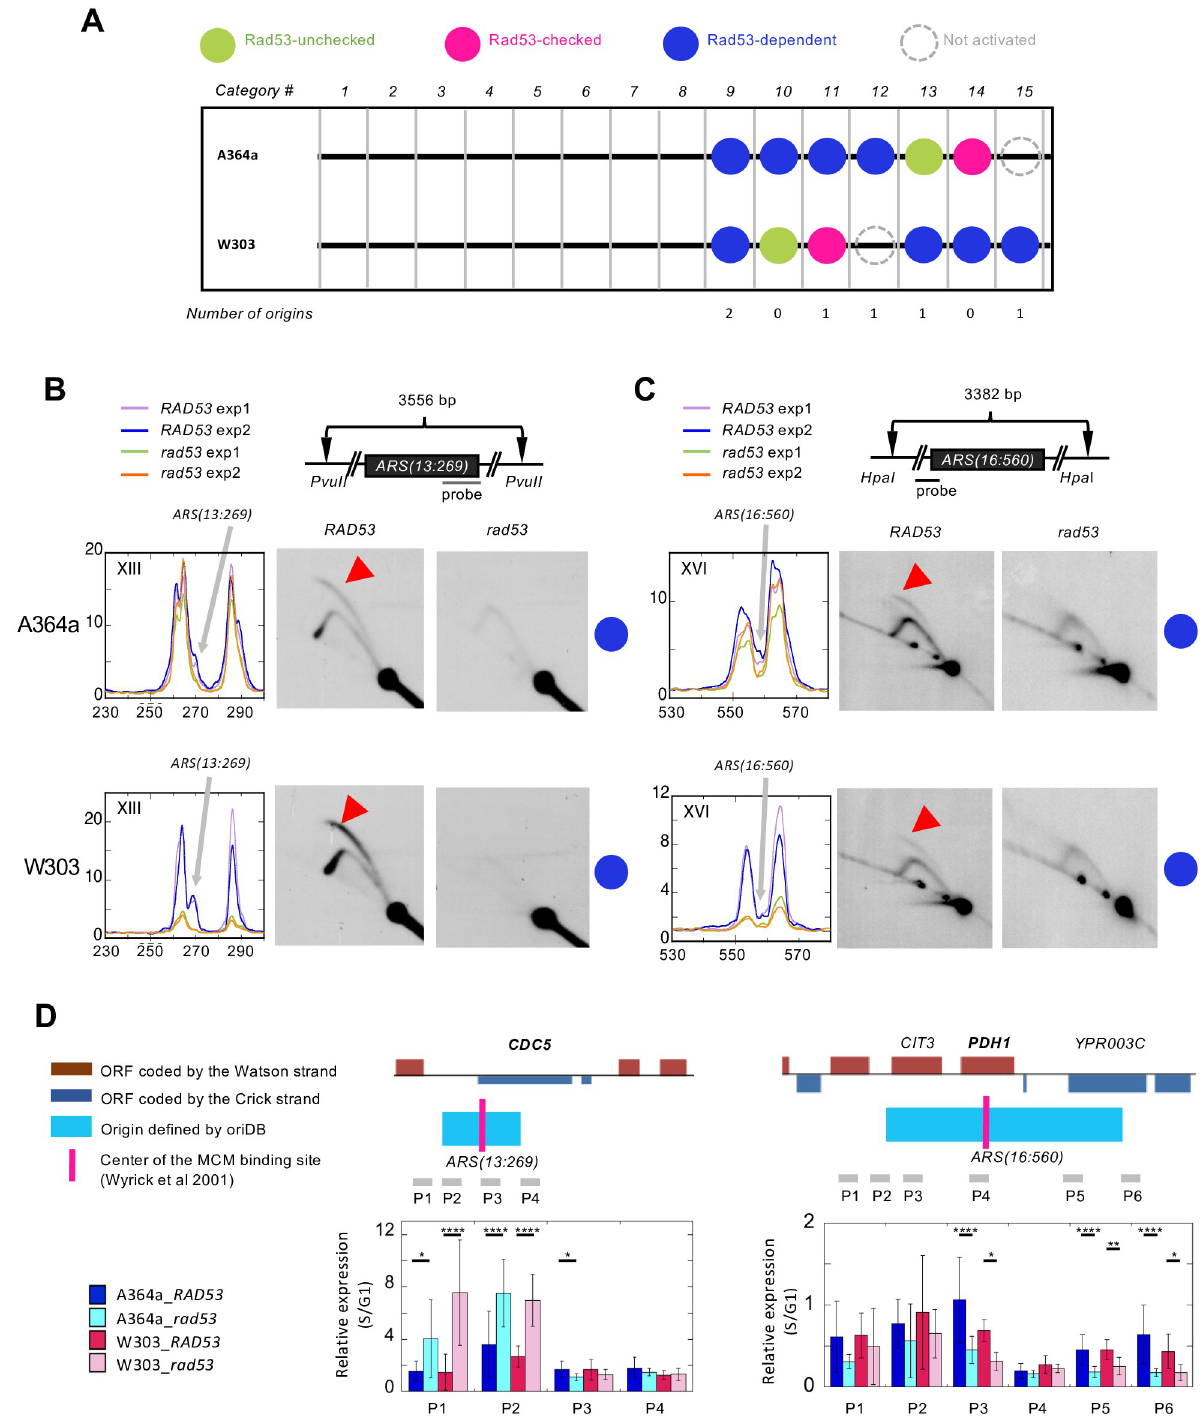
Fig 6. Rad53-dependent origins. (A) Numbers of Rad53-dependent origins parsed into the shown categories. (B & C) 2-D gel validation of ARS (13 : 269) and ARS(16 : 560) performed similarly as described in Fig 4. (D) Relative gene expression levels (S/G1) at genomic loci of Rad53-dependent origins that overlap with ORFs. The relative locations of the origins and location of ORC binding sites are derived from OriDB. The ORF that is nearest to the ORC binding site is bolded in each locus. The primers (P#) used for RT-qPCR are shown as a light grey bar, not drawn to scale.